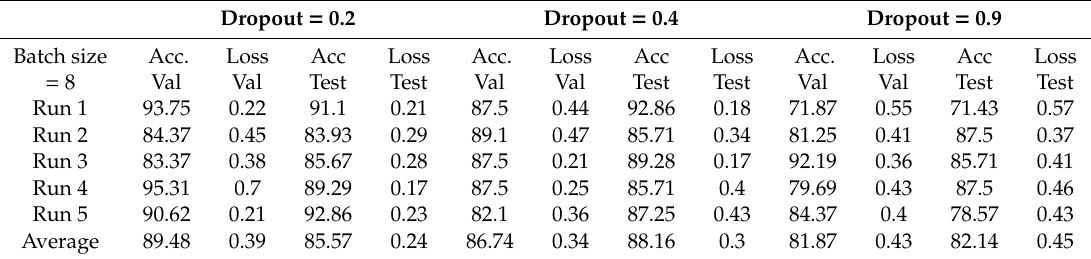
Table A2. CNN Model (epochs = 200, pixel = 200 × 200, conv (8- > 16- > 32), dense = 64) runs for di ff erent dropouts.